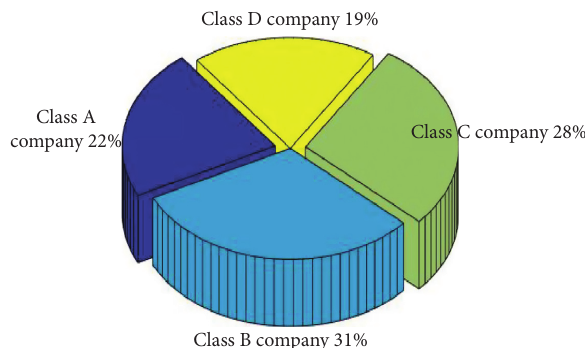
Figure 3: Visual pie chart of business classification with loan records.